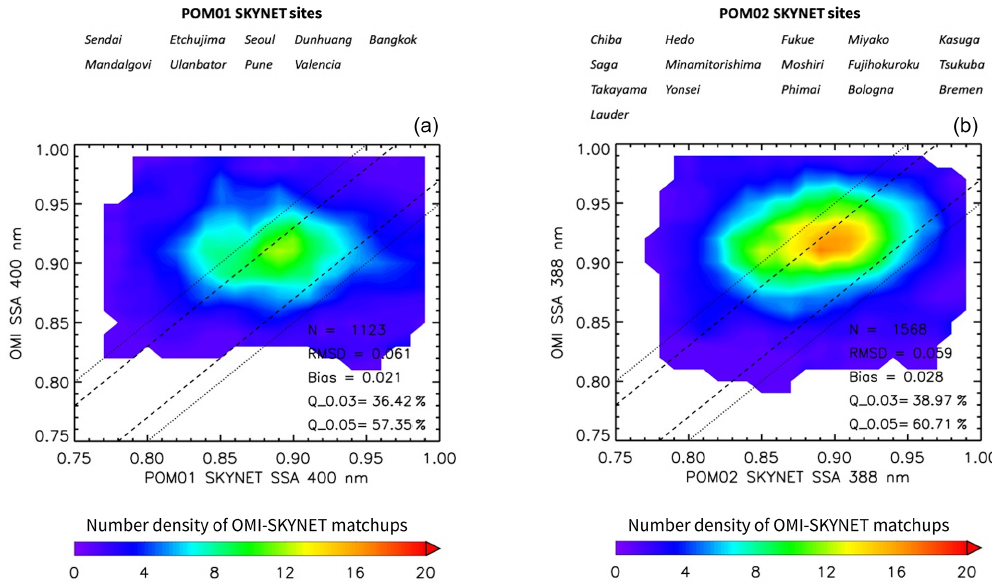
Figure 6. Composite number density contour plots of the SSA comparison between OMI and SKYNET for POM-01 (a) and POM-02 (b) sensors separately. The resultant statistics of the comparison are depicted in the lower right of both